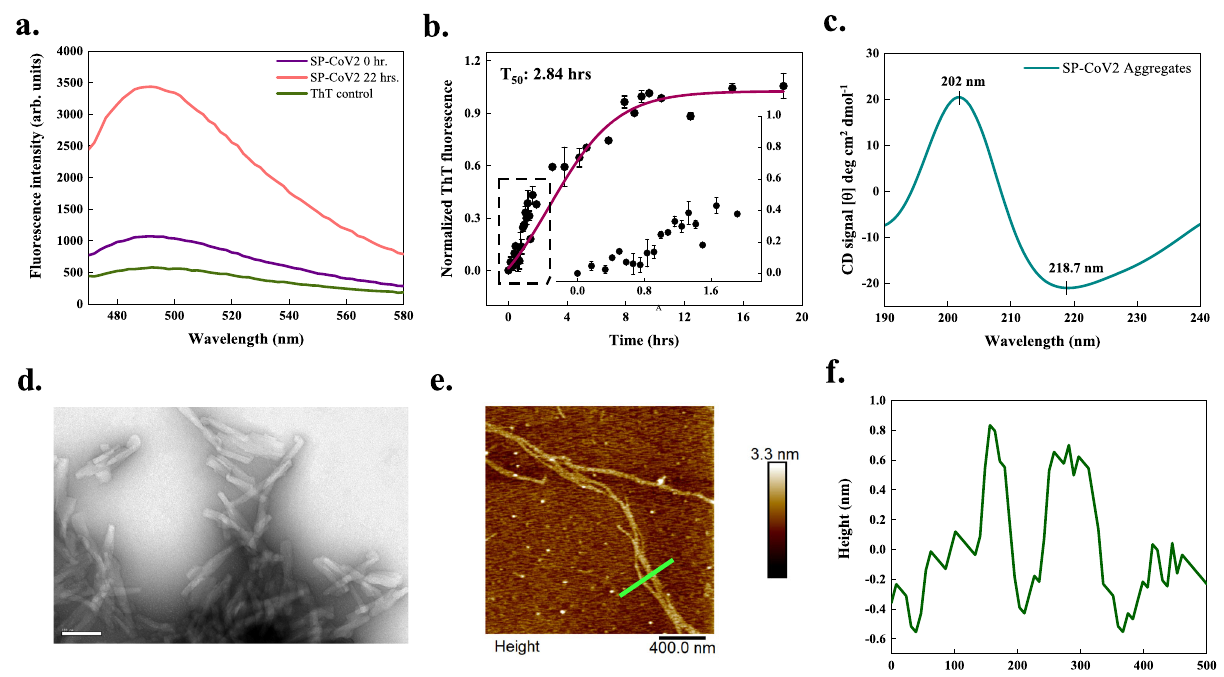
Fig. 2 | In vitro aggregation of signal peptide (SP-CoV2) of SARS-CoV-2 S protein. a ThT fl uorescence scan ( λ ex 440nm) shows a ~3-fold increase at λ max in presence of SP-CoV2 at 22h. b Aggregation kinetics monitored using ThT fl uor- escence at 490nm. Each dotted symbol represents the average value of two technicalreplicatesand errorbarrepresentstheSEMofthesereplicates.Thewine- coloured line shows the sigmoidal fi tting of data points that determines the T 50 of this reaction to be 2.84±0.43h. The aggregation kinetics shows a short lag phase that can be seen in the inset. c Secondary structural analysis of 0.25mg/ml aggregates (240h) using CD spectroscopy reveals two peaks having positive